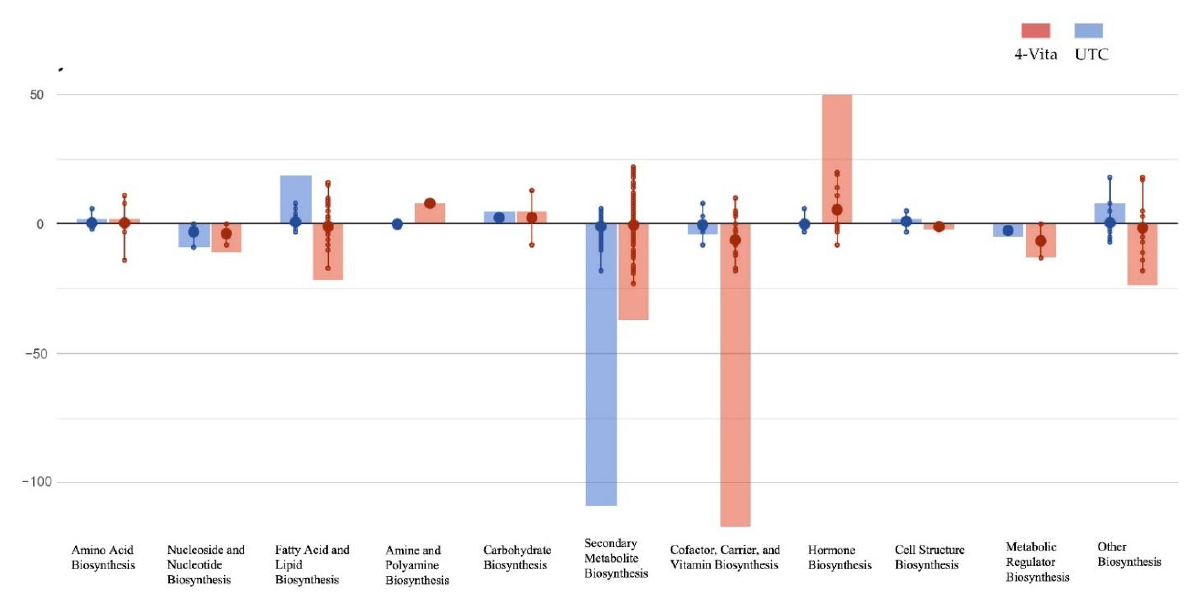
Figure 5. Metabolic biosynthetic processes modulated in tomato leaves following the treatments with 4-Vita under drought conditions, compared to untreated control (UTC). The x -axis represents each set of metabolic subcategories, while the y -axis corresponds to the accumulative Log fold change (Log FC). The large dots represent the average (mean) of all Log FCs in the class, whereas small dots represent individual Log FC values. Abbreviations: AA: amino acid, Nucleo: nucleotide, FA/Lip: fatty acid and lipid, Carbo: carbohydrate, Sec Metab: secondary metabolites, Cell struct: cell structure, Metab Reg: metabolic regulation, Syn: synthesis. Table 6. Biosynthetic processes modulated by 4-Vita in tomato plants under drought stress, compared to untreated control